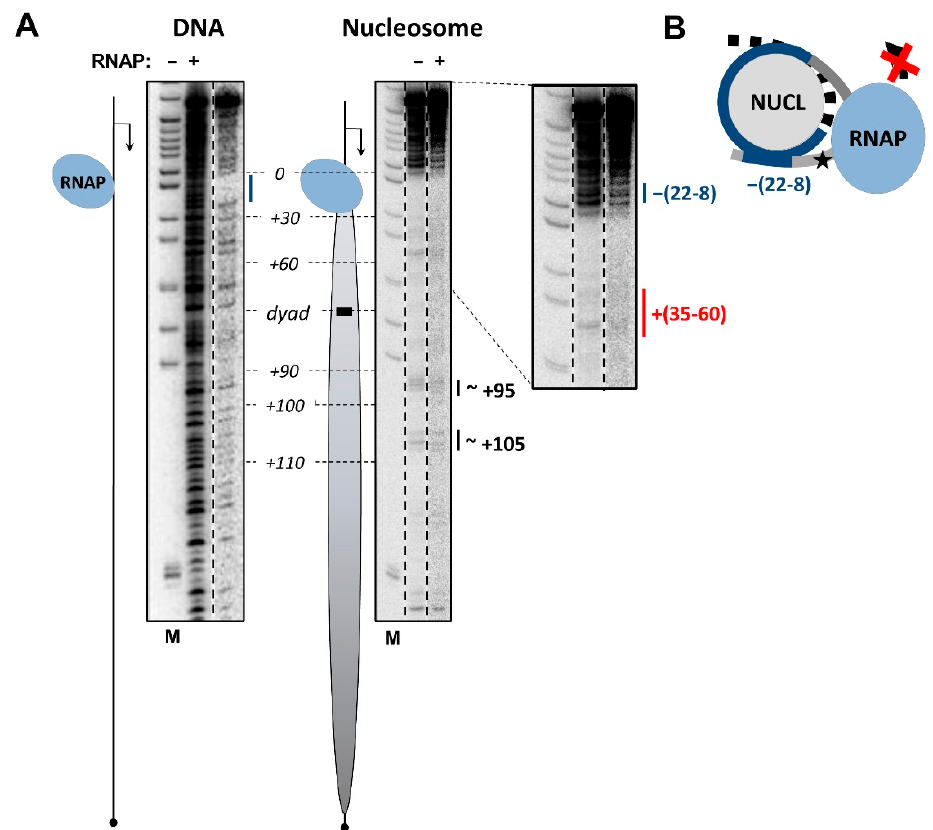
Figure 3. EC+20 containing ssDNA break is flanked by DNA-histone interactions. Analysis of EC+20 structure using DNAse I footprinting. ( A ) EC+20 was formed on the 603 DNA or in the nucleosome containing single ssDNA break after 12th nucleotide (+12 SSB), as described in Figure 1. Analysis of end-labeled DNA (template strand) by denaturing PAGE. Position of the nucleosome on the template is shown by an oval; the direction of transcription is indicated by an arrow. The region protected from DNase I by RNAP on DNA is shown by the blue line. The region of additional protection in EC+20 as compared with intact nucleosome is shown by the blue line. The region of minor additional sensitivity is shown by red line. Note the DNA regions protected from DNase I both upstream and downstream of transcribing RNAP, indicating the formation of an intranucleosomal DNA loop (i-loop). ( B ) Schematic drawing of EC+20 containing SSB: formation of the i-loop. Asterisk indicates the position of +12 SSB on DNA.